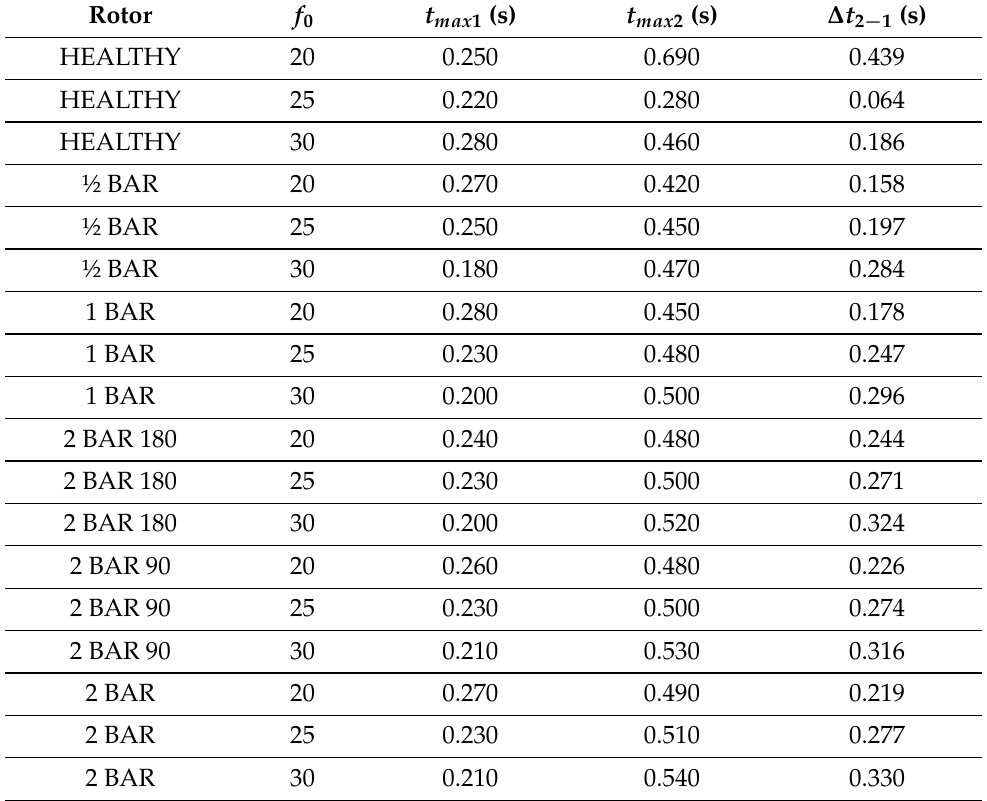
Table 1. Interval between Teager energy maximums.